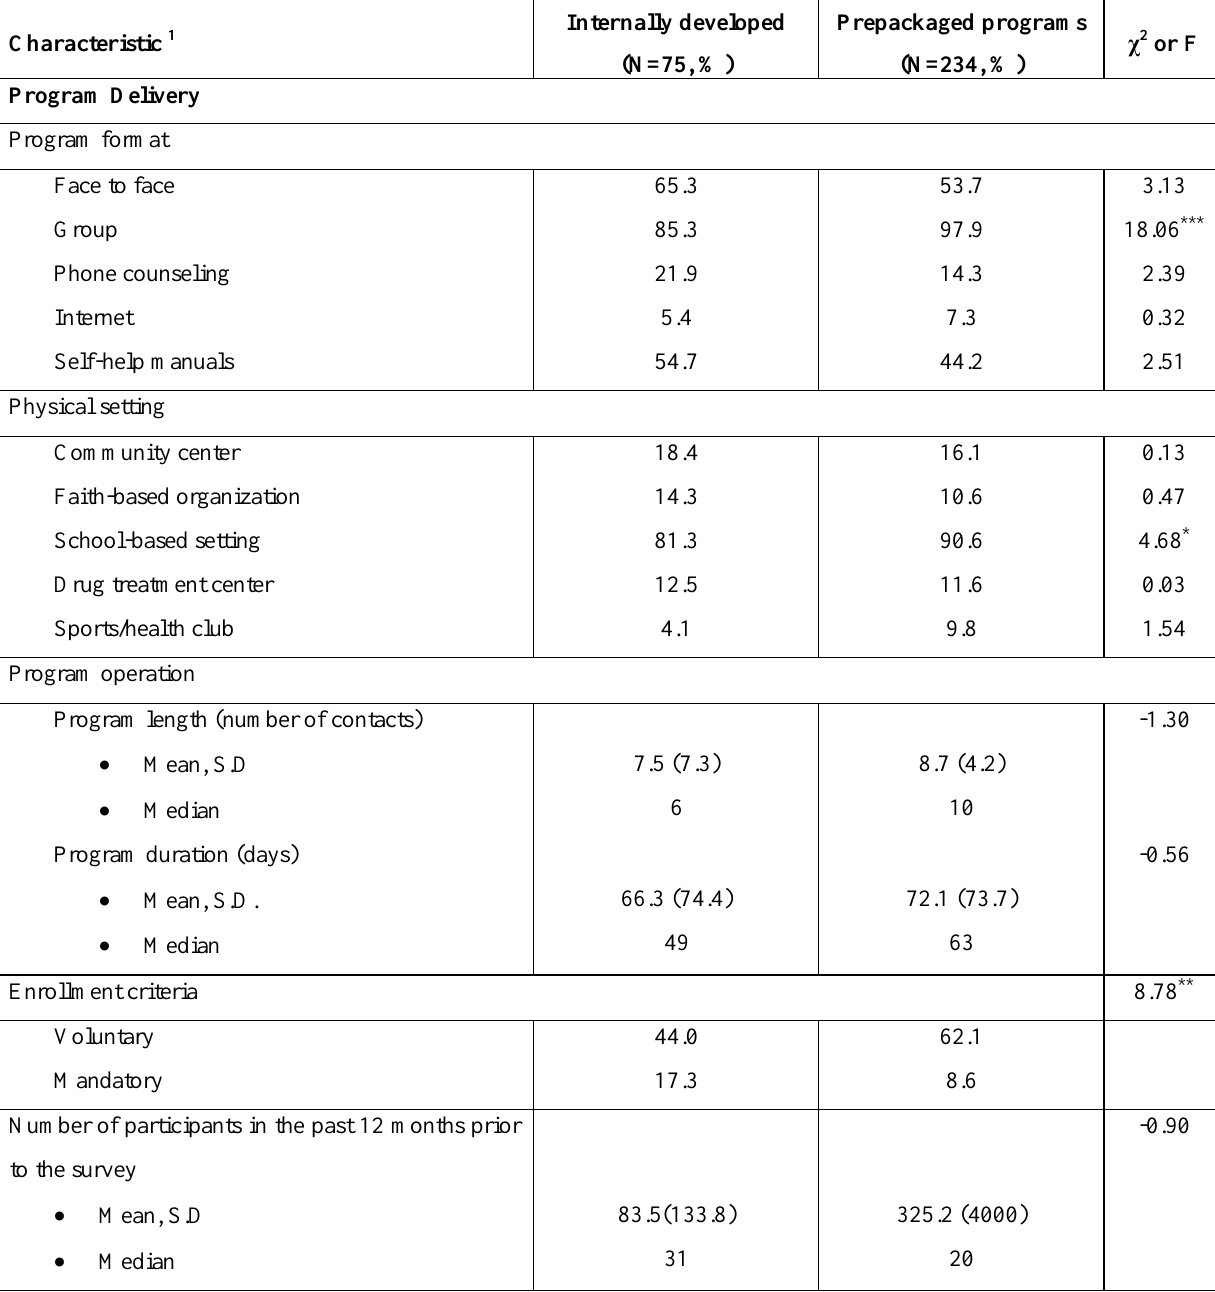
Table 2. Implementation and content of internally-developed and prepackaged